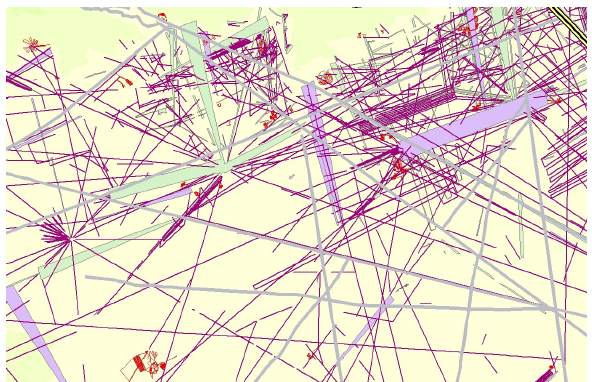
Figure 1. Cut from map a colors of geoglyphs: red – figures, purple – lines, purples area - closed areas shapes, green area – unslosed areas shapes.